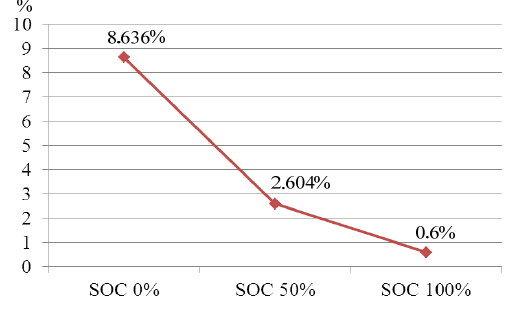
Figure 23. The estimation errors of the AC impedance